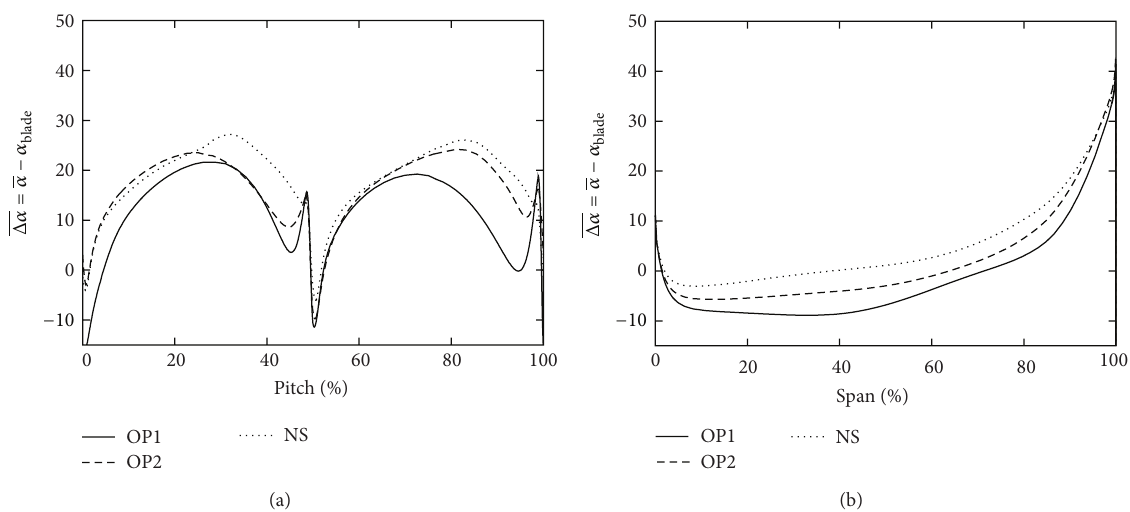
Figure 11: Time-averaged pitchwise distribution at 90% span (a) and axisymmetric profile (b) of the incidence angle, 1mm after the impeller exit.